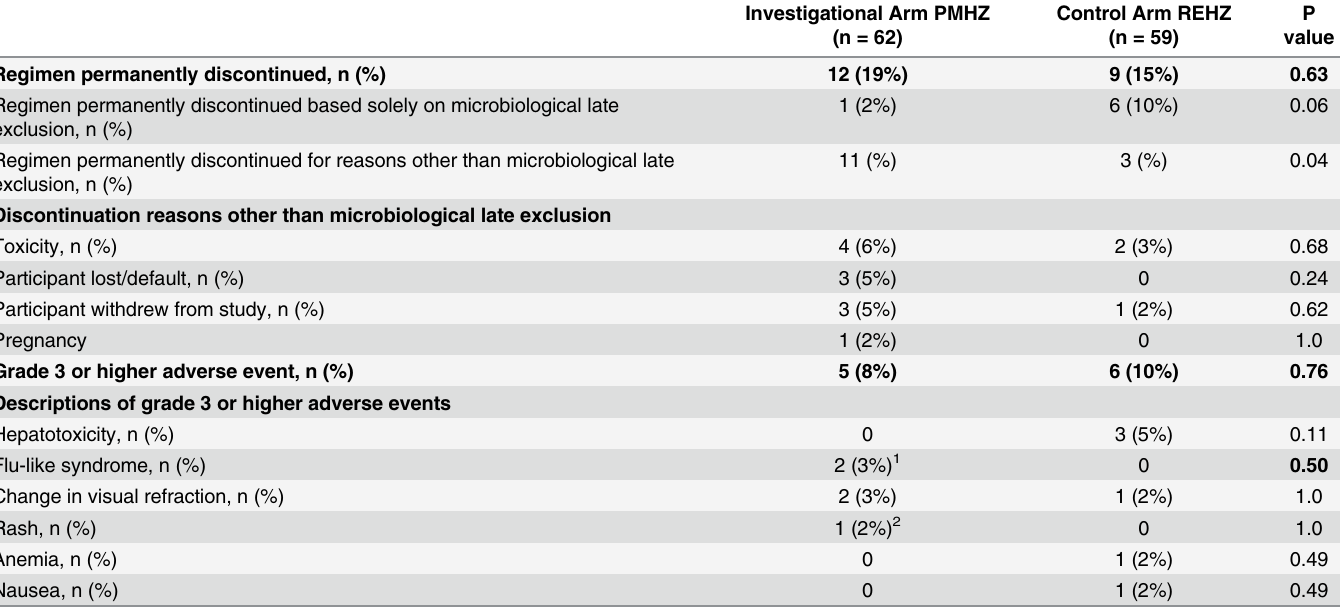
Table 3. Discontinuation of assigned treatment during the intensive phase, and adverse events within the first 70 days after the initial dose of study drugs. Notes: 1 : The study regimen was discontinued in both participants. In one participant the re-introduction of isoniazid replicated the flu-like symptoms experienced while on the study regimen. In the other participant the re-introduction of rifapentine or pyrazinamide replicated the flu-like symptoms experienced while on the study regimen. 2 : The study regimen was discontinued. The rash recurred with re-introduction of